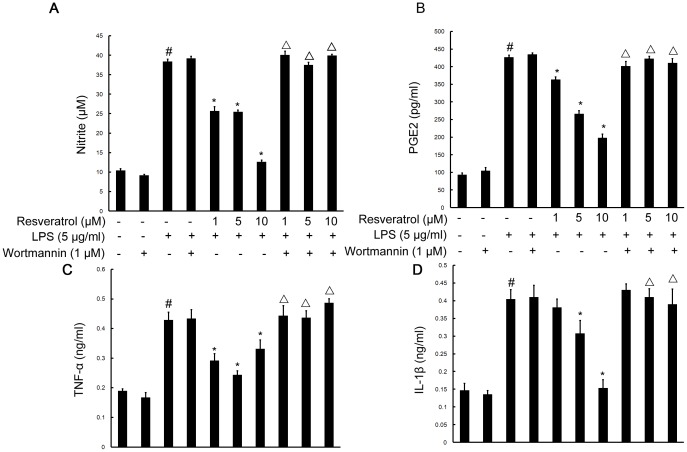
PI3-K is required for resveratrol-inhibited the production of NO, PGE2, TNF-α and IL-1β induced by LPS in RAW 264.7 macrophage cells.Approximately 1×106 cells/ml were seeded in six-well plates and incubated until 80% confluency. Cells were pre-treated with resveratrol (1, 5, and 10 µM) for 1 h in the absence or presence of wortmannin (1 µM), then exposed to LPS (5 µg/ml) for 12 h. The concentrations of NO (A), PGE2 (B), TNF-α (C) and IL-1β (D) were measured as described in the methods. The values shown are mean ± SEM of data from three independent experiments. #Significant compared with control alone, p<0.05. *Significant compared with LPS alone, p<0.05. ΔSignificant compared with resveratrol + LPS, p<0.05.